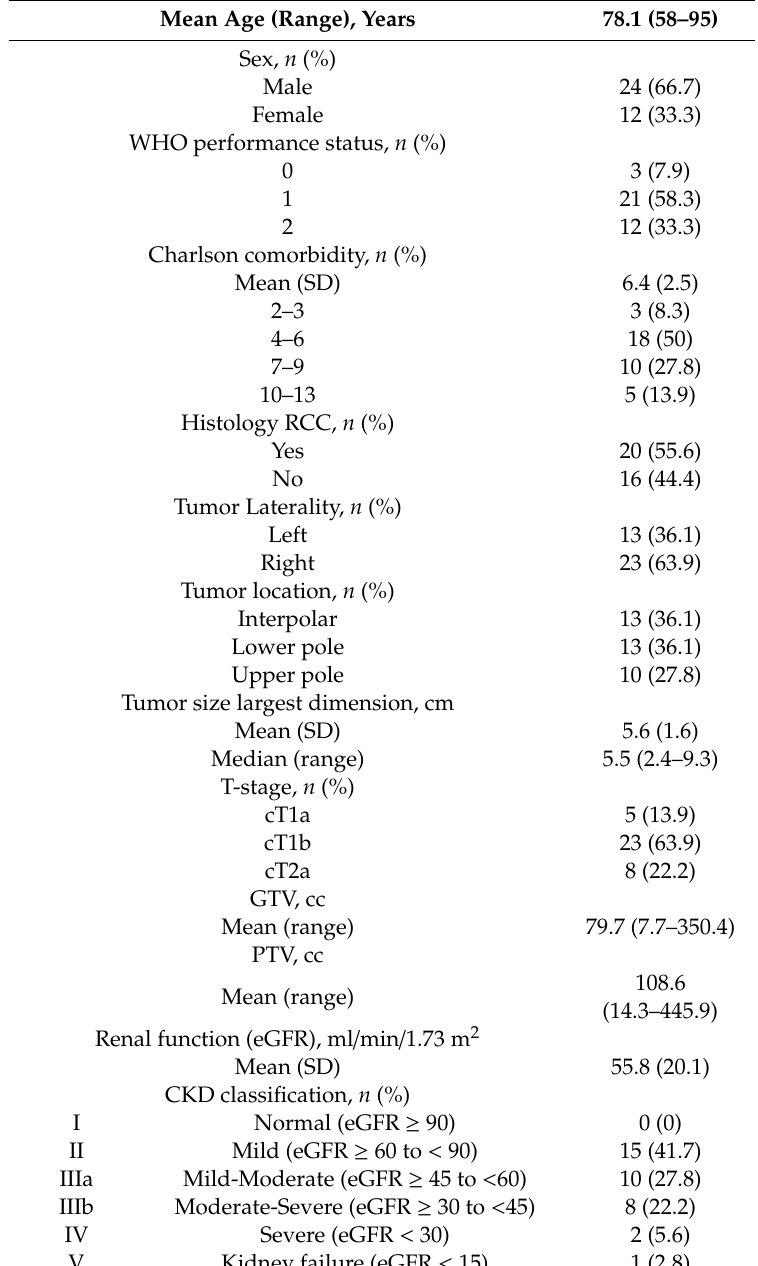
Table2. Baselinepatientcharacteristics( n = 36). Abbreviations: RCC = renalcellcarcinoma, GTV = gross tumor volume, PTV = planning target volume, CKD = chronic kidney